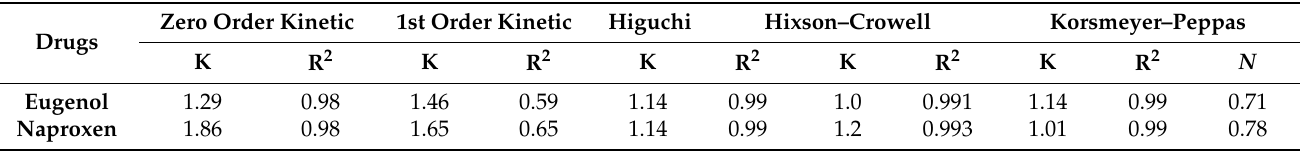
Table 7. Drug release kinetics of optimized